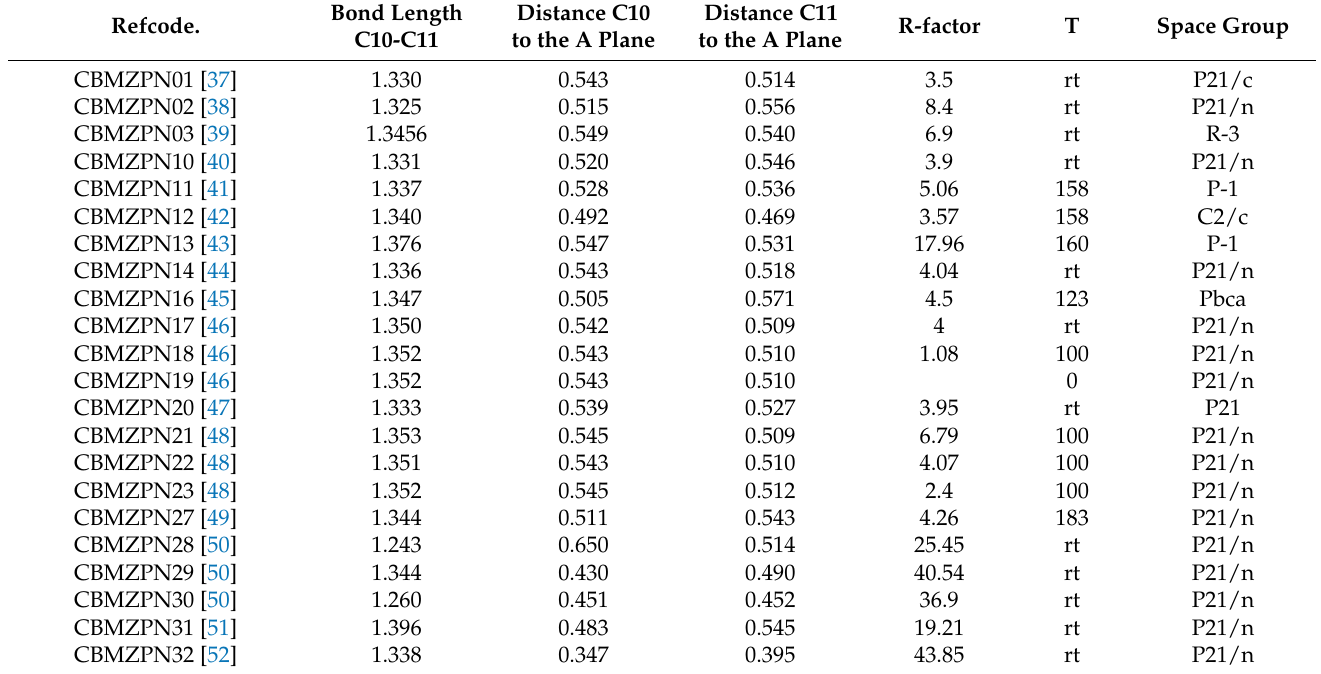
Table 4. Geometry parameters for carbamazepine structures from CSD crystal database.